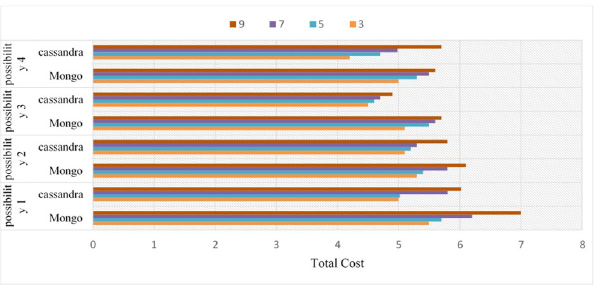
Fig 21. Performance variables for Cassandra compared with those for Mongo DB on star